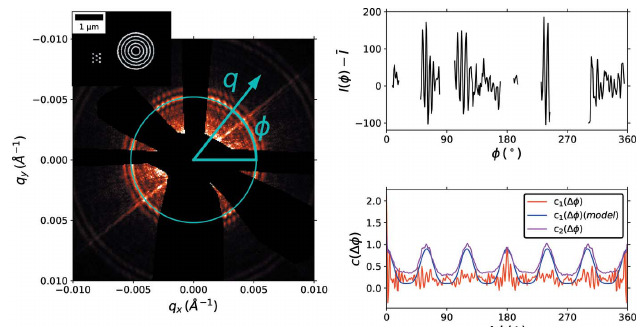
Figure 3 Diffraction pattern measured for a sample (3 (cid:11) 3 hexagonal array) in the presence of an amplifier (concentric ring structure). The corresponding SEM is shown in the upper left. The ring along the blue contour is remapped to a (average-subtracted) one-dimensional curve versus (cid:3) (top right). The first- and second-order angular correlations are plotted in the lower-right figure. The first-order correlation (red) is flat and noisy. However, the second-order correlation function (magenta) closely matches the idealized expectation for the known sample symmetry (blue). The interference fringes oscillate as the inverse sample–amplifier distances ’ 2 (cid:7) /1 m m ’ 6 (cid:11) 10 (cid:3) 4 A˚ (cid:3) 1 .